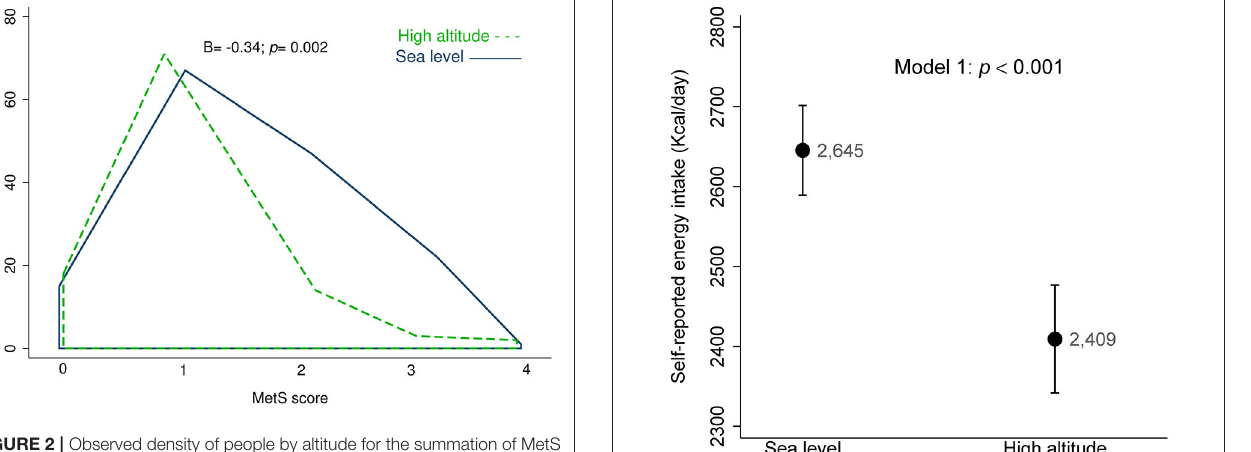
FIGURE 2 | Observed density of people by altitude for the summation of MetS components (MetS score) . The high altitude is represented by the area under the green dashed line, and sea level area is displayed under the blue solid line. Model 1 adjusted for: age, sex, self-reported energy intake and residence time. B, Beta regression coefficient; p , p-value.